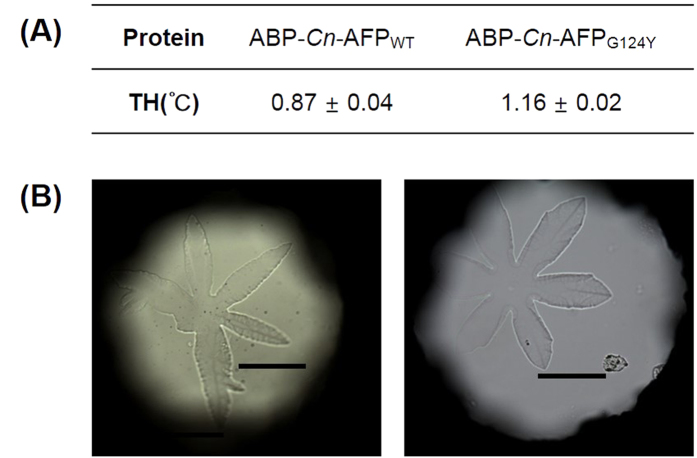
Antifreeze activities of ABP-Cn-AFP proteins.(A) Thermal hysteresis (TH) values of ABP-Cn-AFPWT and ABPG124Y. (B) Ice crystal morphology in the presence of ABP-Cn-AFPWT and ABP-Cn-AFPG124Y. The ice crystals showed burst patterns in the presence of both proteins. Scale bars: 100 μm.